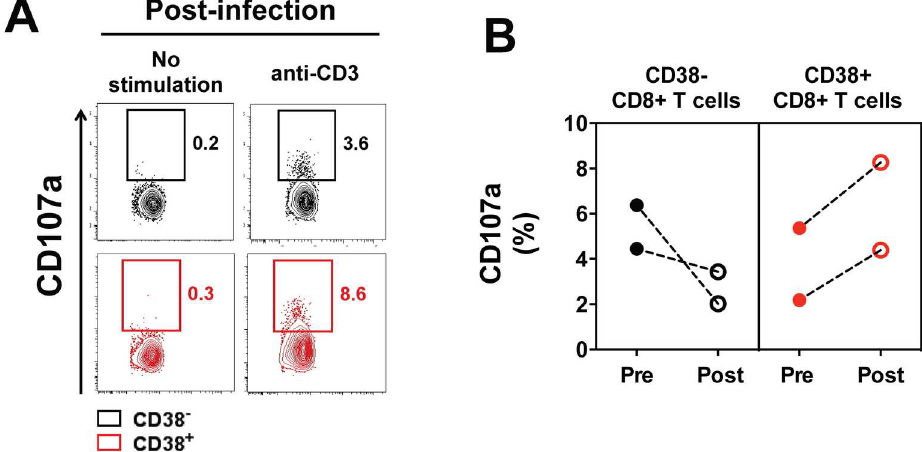
Fig 4. Degranulation in circulating CD38 + and CD38 - CD8 + T cells following P . vivax blood-stage infection. Blood samples were collectedfrom malaria-naive volunteersprior to and post-infection with P . falciparum or P . vivax infected erythrocytes, as describedin legendto Fig 1. Degranulation of CD38 + and CD38 - CD8 + T cells was determined by flow cytometry using a CD107a-based degranulation assay on sorted cells after five hours stimulationwith plate-bound anti-humanCD3 (10 μ g/mL). (A) Representative stainingof CD107a in circulating CD38 + and CD38 - CD8 + T cells from one P . vivax infected volunteer. (B) Frequencyof CD107a + cells after stimulation(background subtracted)in circulating CD38 + and CD38 - CD8 + T cells pre- or post-infection in P . vivax infected volunteers. Graphs show mean data from 2